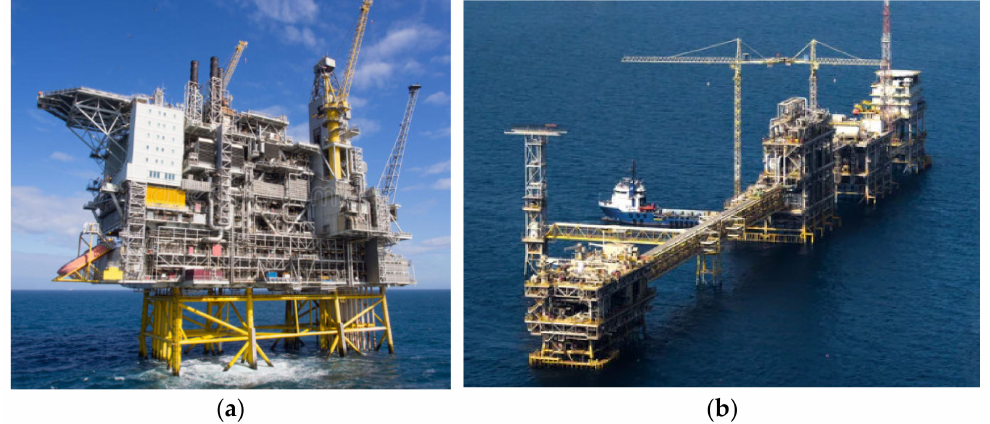
Figure 4. Typical platforms showing ( a ) conventional jacket platforms and ( b ) bridged fixed jacket platform on Zuluf oil field in Arabian Gulf, offshore northeast Saudi Arabian coast, with the water depth of about 40 m (Image ( b ) Courtesy: Saudi